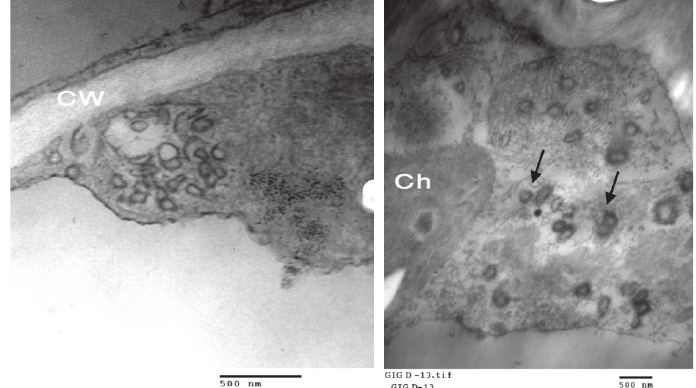
Figure 3. Groups of Double-membraned Bodies (DMB) in the cytoplasm of mesophyll cells from a naturally infected fi g. Arrows indicate the aggregates of convoluted electron-dense double membrane elements. Ch, chloroplast, CW, cell wall, Bar = 500